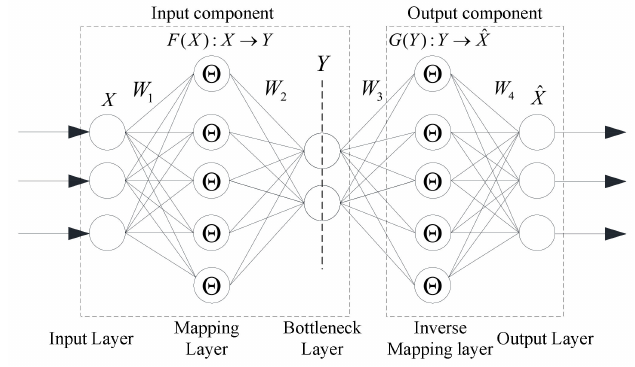
Figure 1. NLPCA network structure based on